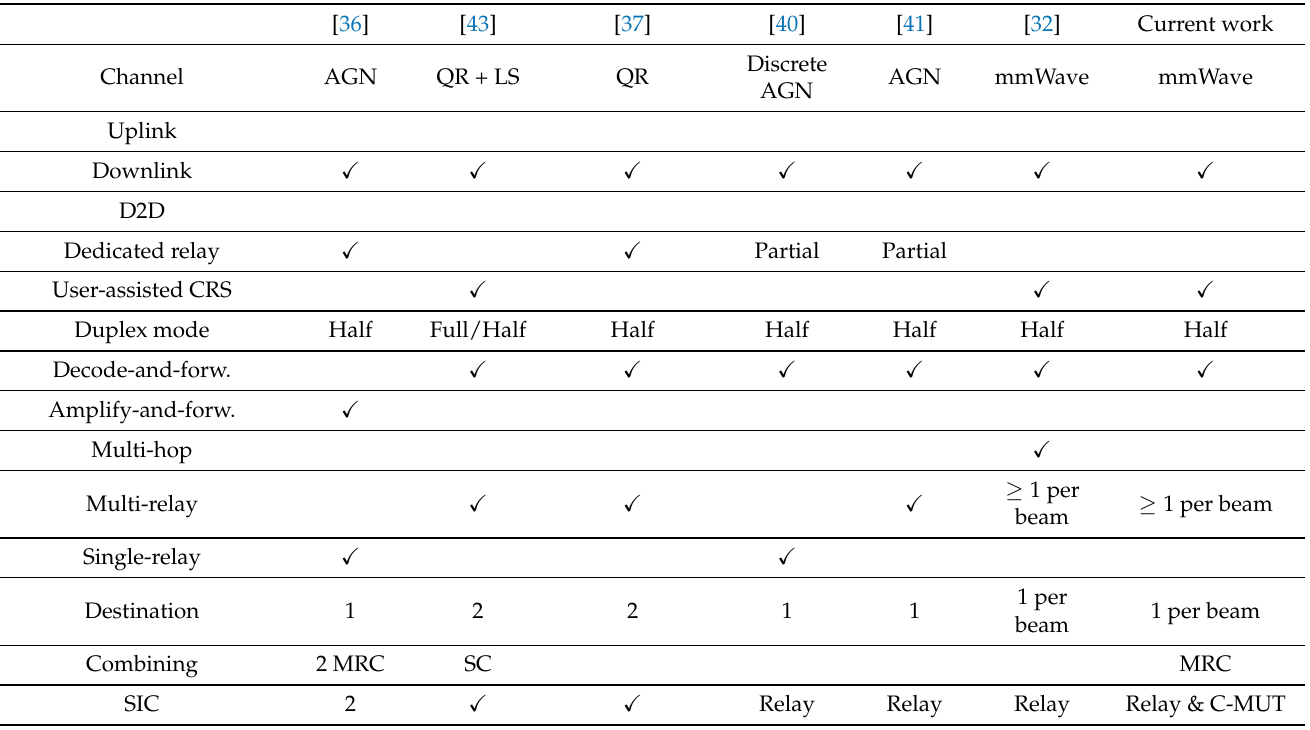
Table 1. A list of the distinctions between the suggested method and some relevant